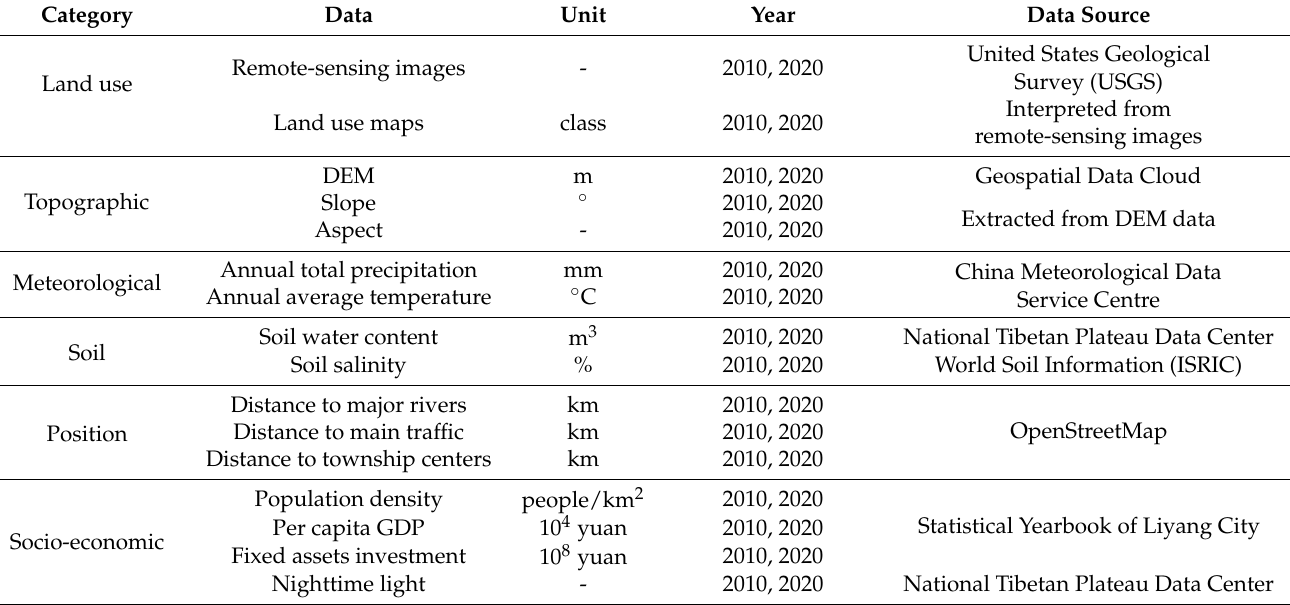
Table 1. Data sources and description.